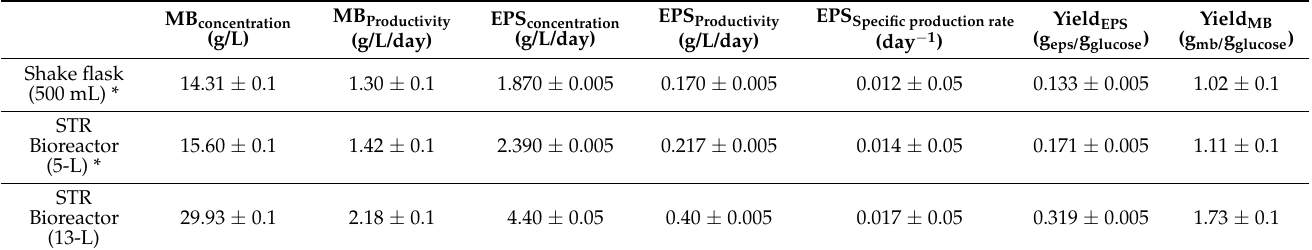
Table 6. Kinetic parameters by L. rhinocerus strain ABI using batch fermentation.